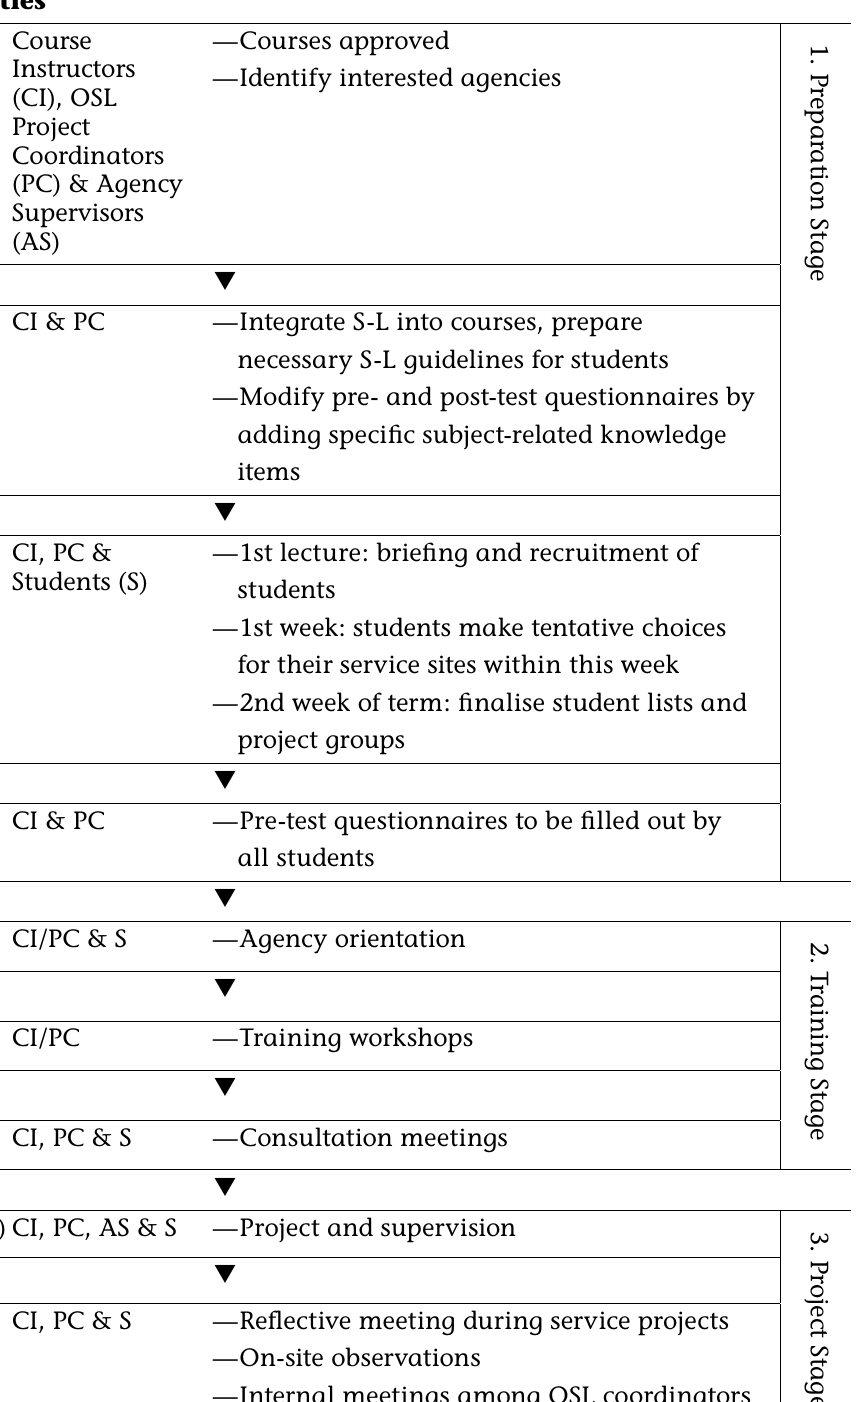
Table 3: Implementation process of the Partially Integrated Course Mode (i.e. departmental